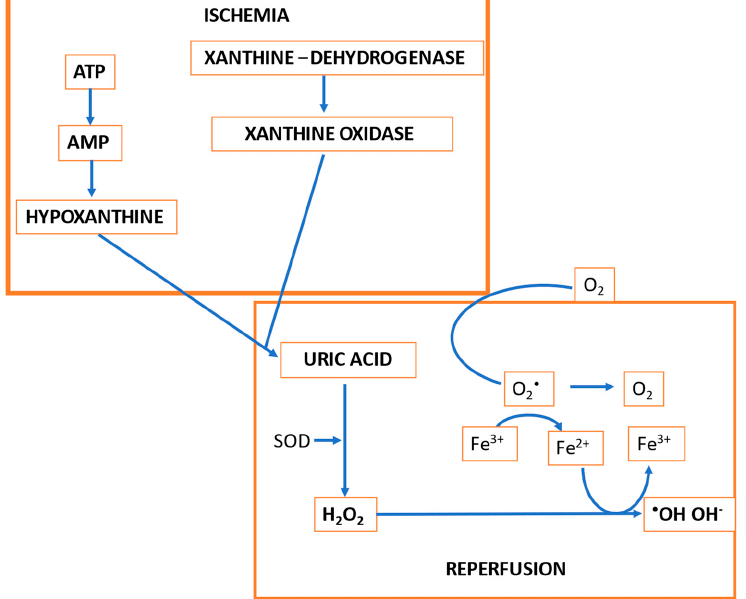
Figure 2. Biochemical events triggering ischemia/reperfusion injury (adapted with permission from Ref. [13] 2022, Piccin Editore ). 4. Ischemia/Reperfusion in Acute Myocardial Infarction and Aftermaths in Brain and Kidneys